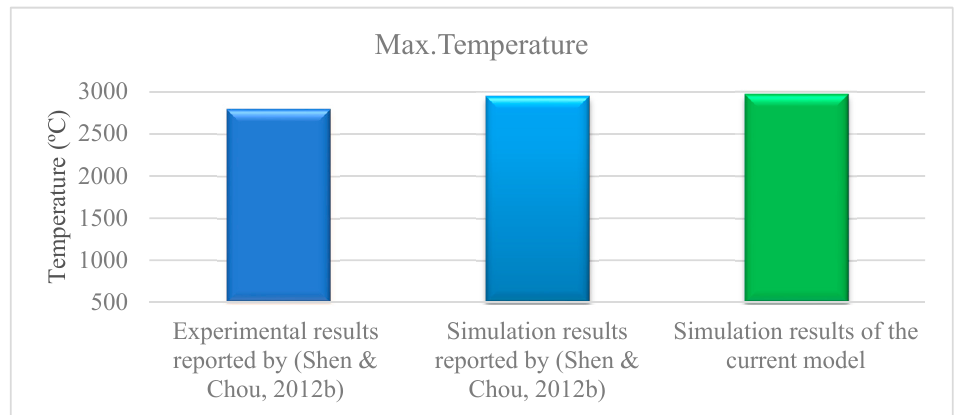
Figure 13. The Maximum temperatures compared with the experimental results.